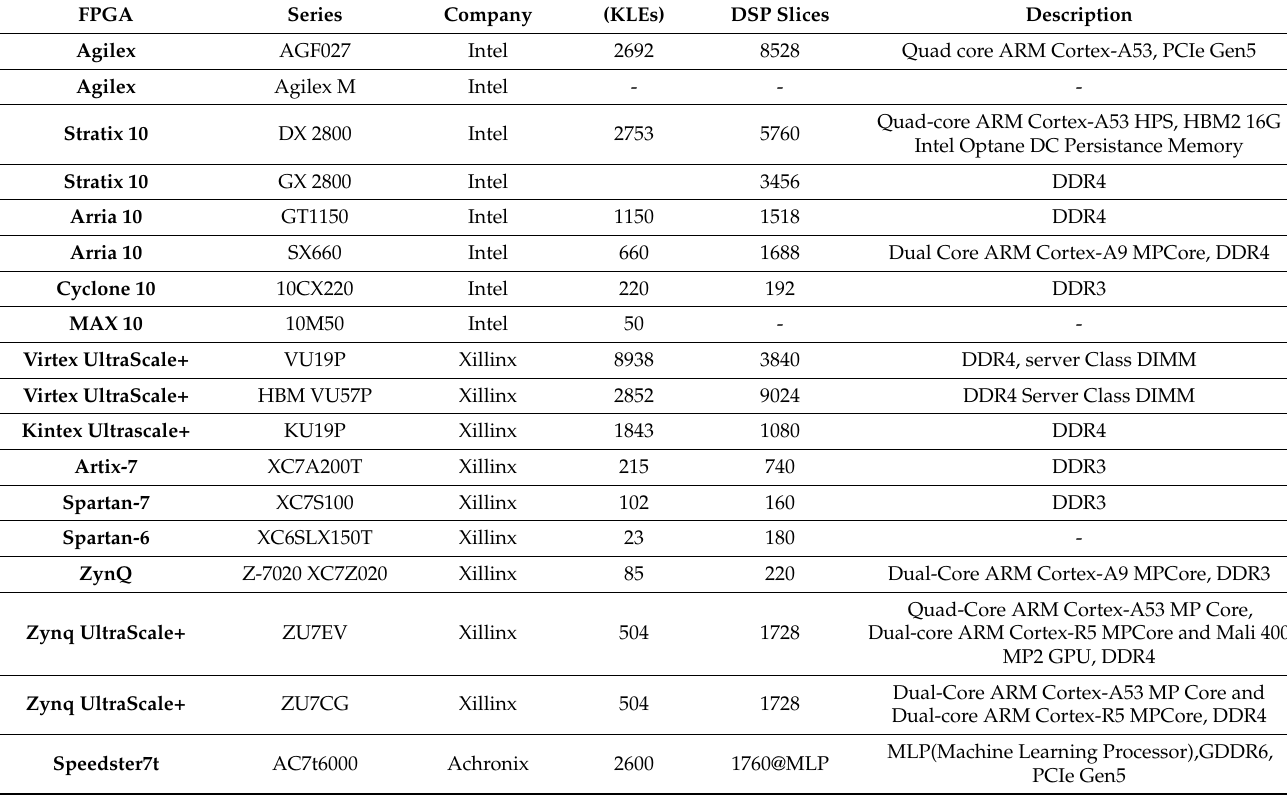
Table 2. Summary Table of FPGA platforms for Intel, Xilinx and